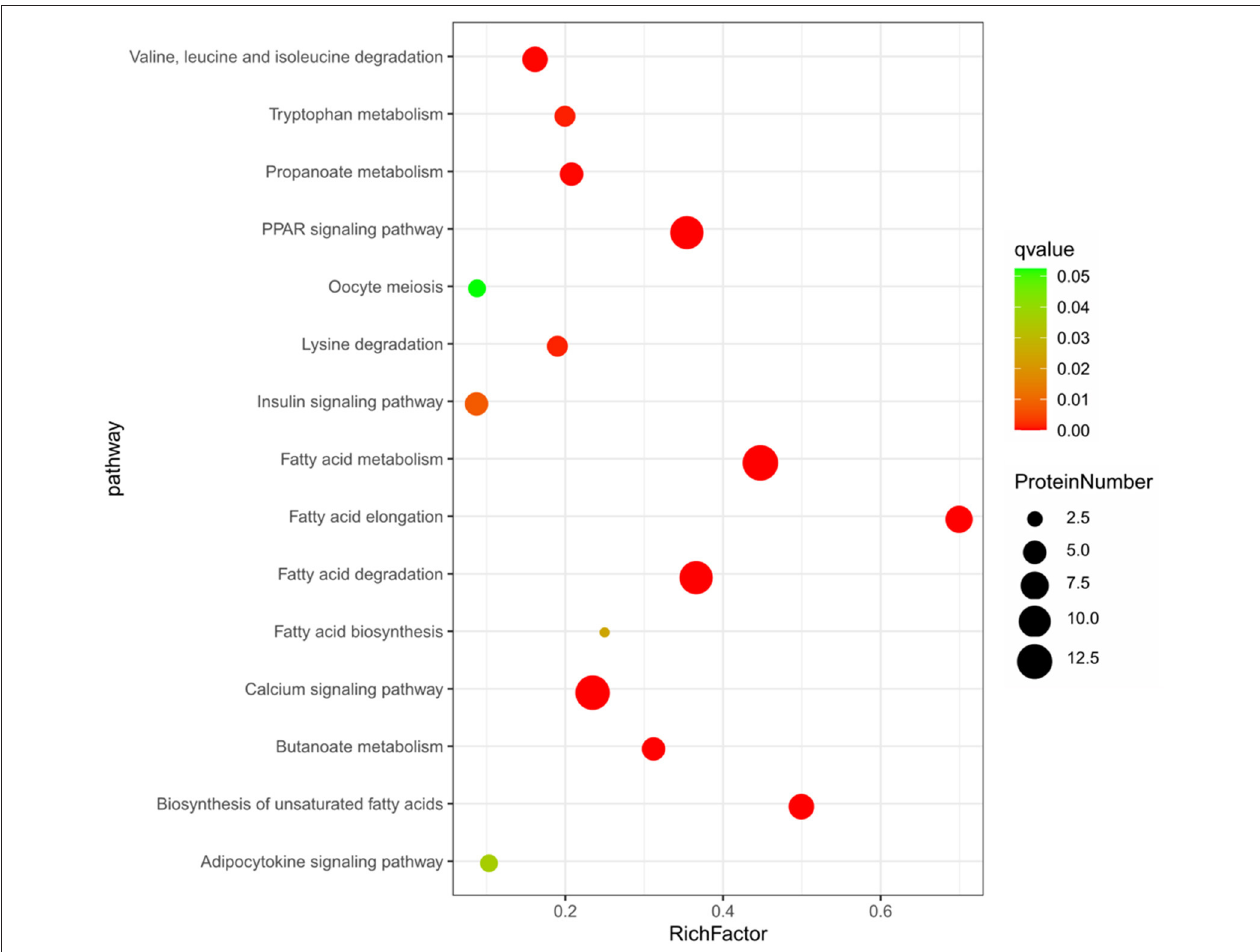
FIGURE 5 | The top 15 enriched KEGG pathway based on the 57 differentially expressed